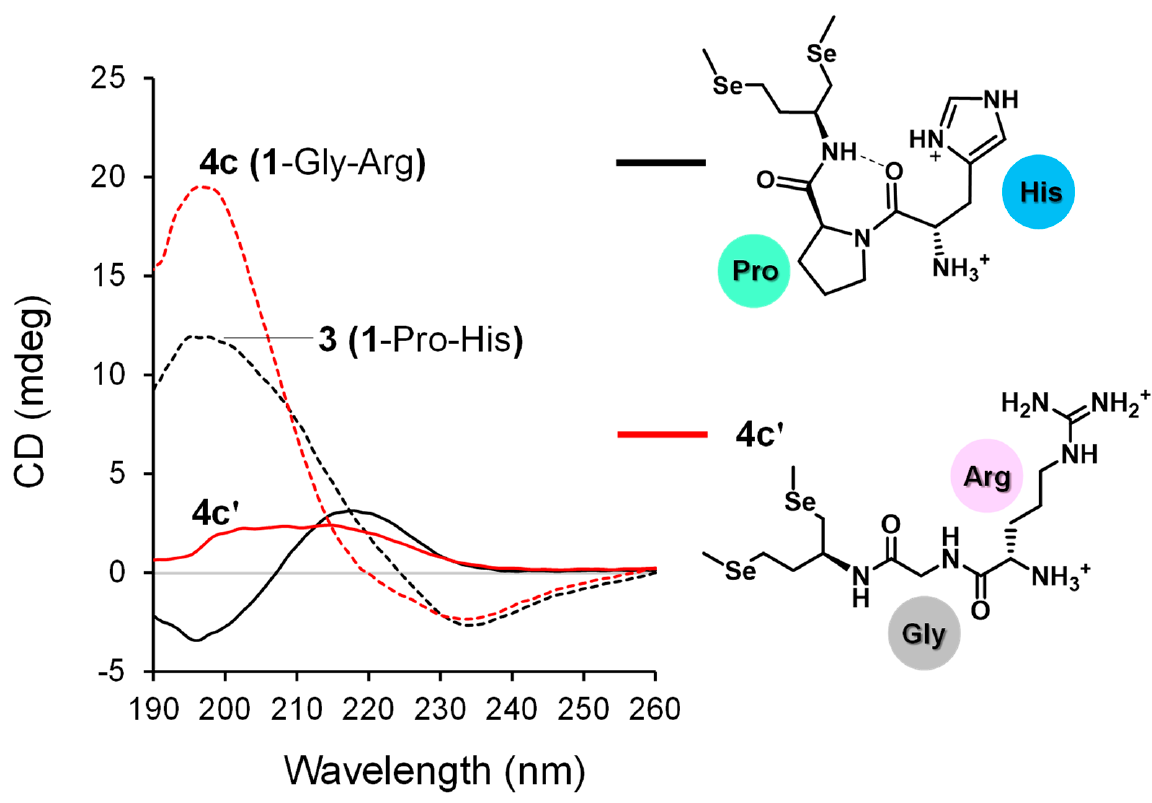
Figure 5. CD spectra of compounds (200 μ M) in 10 mM Tris-HCl buffer solution containing 1 mM EDTA at pH 7.5 and 25 °C. The spectra were determined using a quartz cell (path length = 1 mm). Data of 3 (black dashed line) and its open-chain form (black solid line) were reported previously [28].